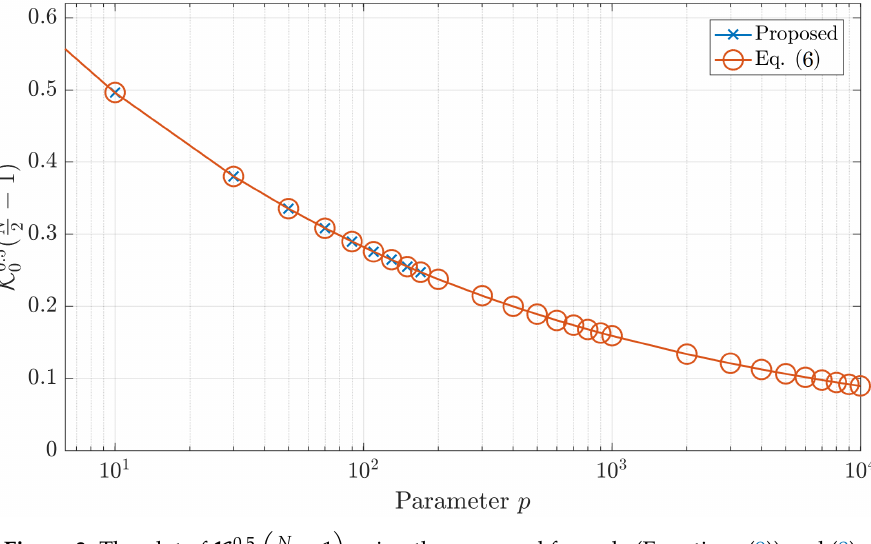
Figure 3. The plot of K 0.5